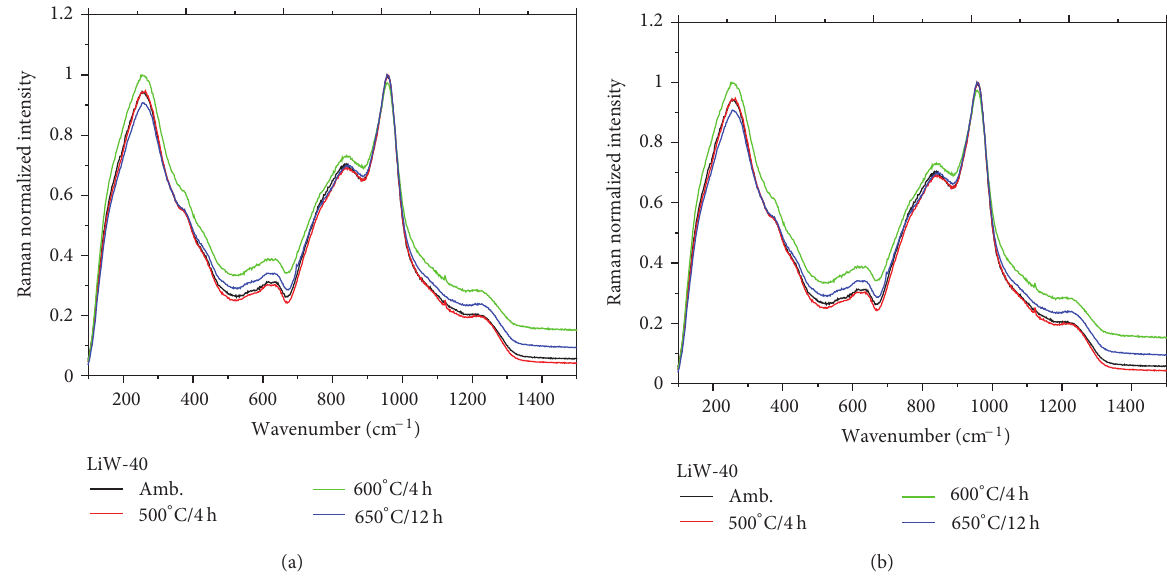
F 4: Raman spectra of AW-40 glasses in the frequency range 100–1500cm